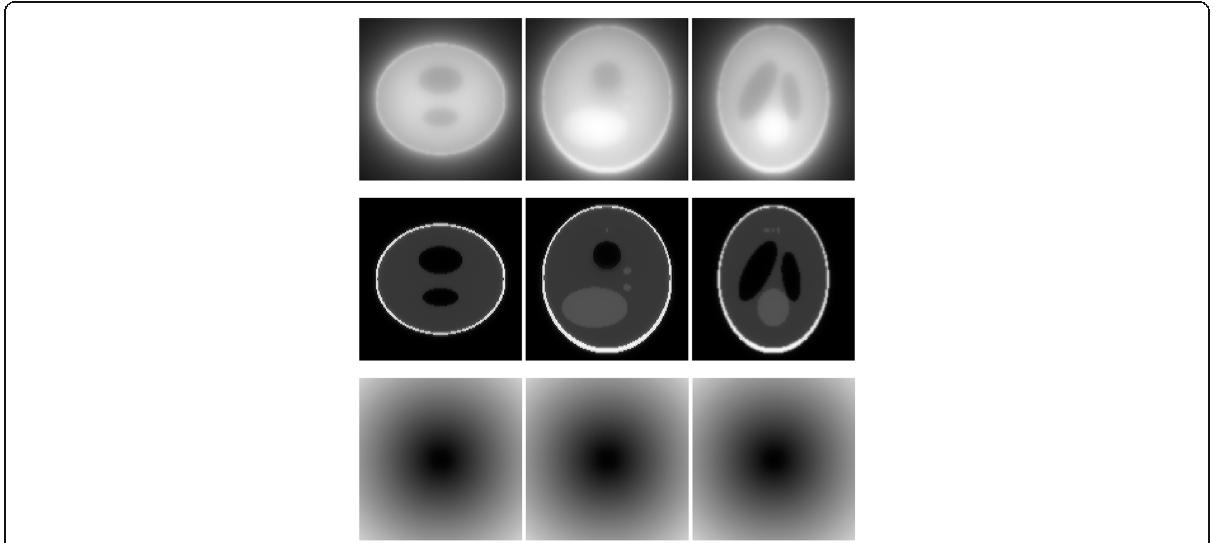
Fig. 14 Image reconstruction using proposed algorithm for the case of ψ = π /2 and σ = 100. This is the ‘ 4 π ’ case. Row 1 : TOF backprojection. Row 2 : Final reconstruction. Row 3 : Tomographic filter H . Three central orthogonal cuts are shown for each row